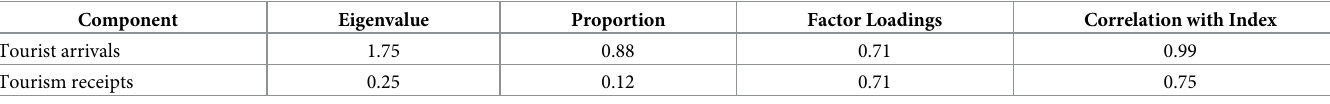
Table 3. PCA results for weighted tourism development